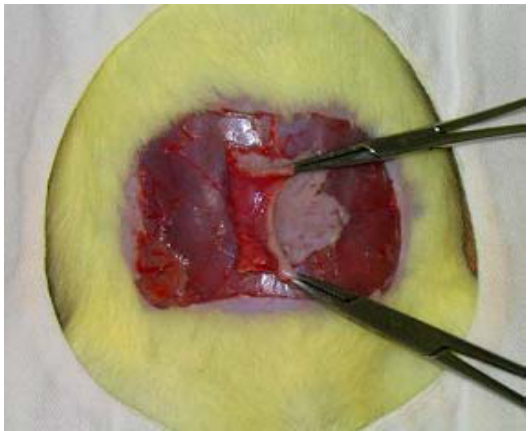
FIGURE 3: Dissection of flap ipsilaterally to pedicle up to lateral margin of rectus abdominis muscle.